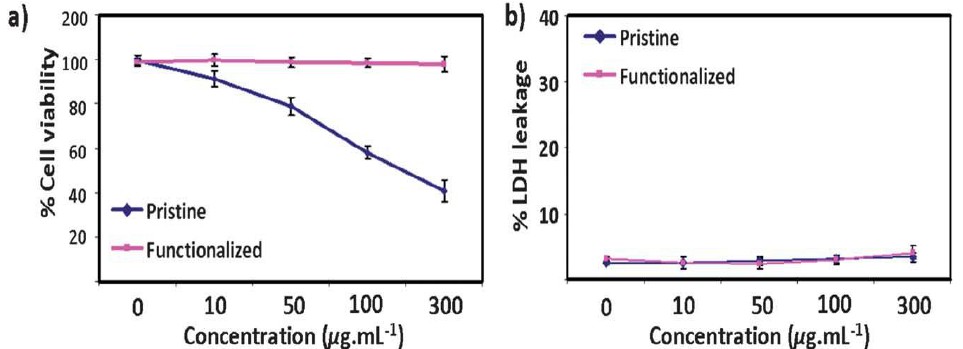
Figure 18. ( a ) Cell viability and ( b ) lactate dehydrogenase (LDH) leakage of Vero cells treated with TRG and f-TRG at different concentrations. Reproduced from [127] with permission of The Royal Society of Chemistry. Table 1. In vitro c ytotoxicity induced by graphene and its derivatives.